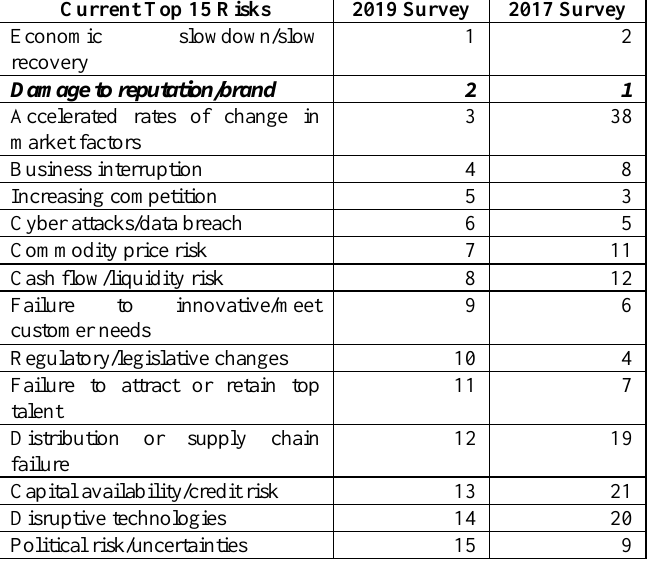
Table 1: Top15 Risks for AON’s 2019 Global Risk Management Current Top 15